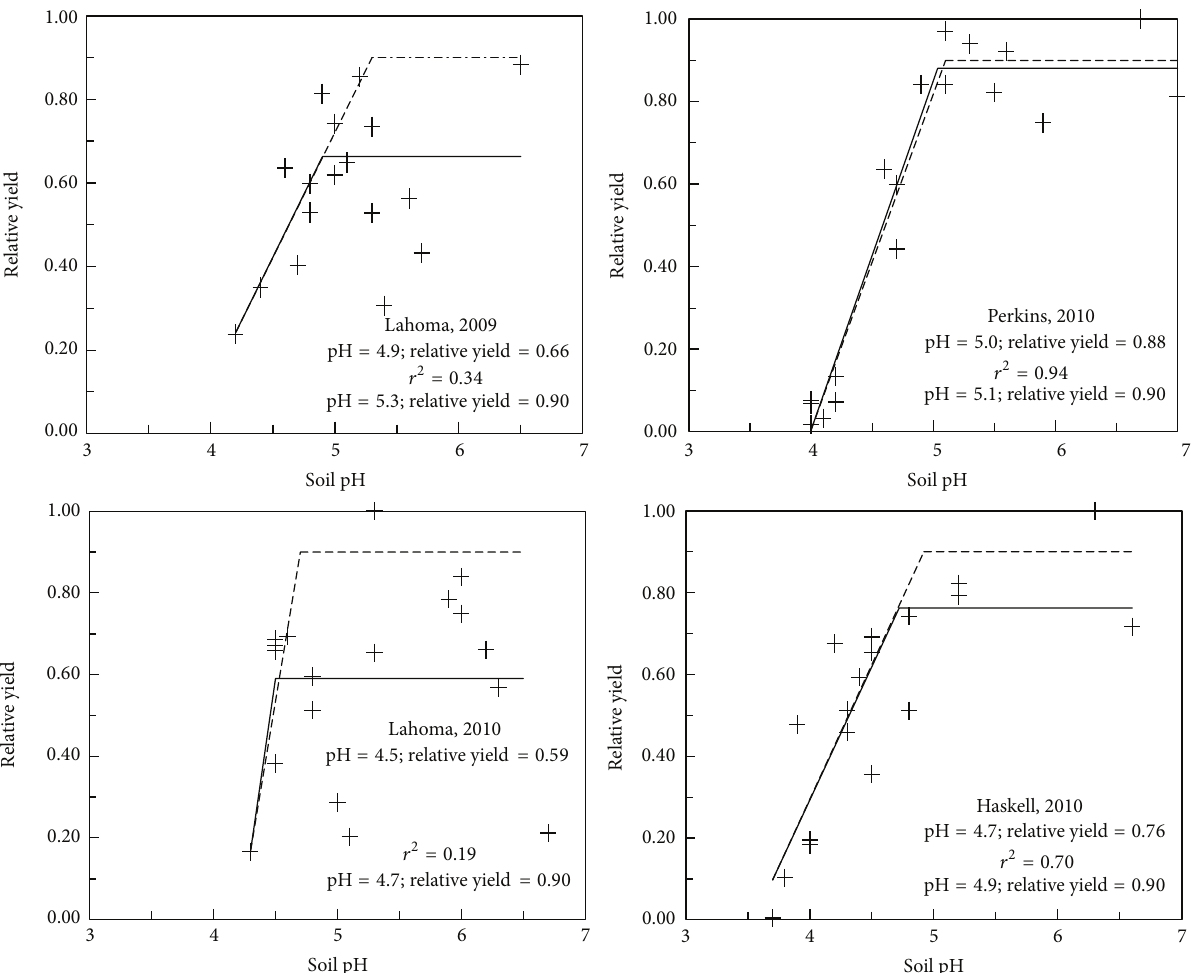
Figure 7: Relative seed yield of sunflower as a function of soil pH at Lahoma, Perkins, and Haskell, OK. Solid lines show where the yield plateau occurred. Broken lines mean yield plateau occurring at 0.90 with critical soil pH (2009 and